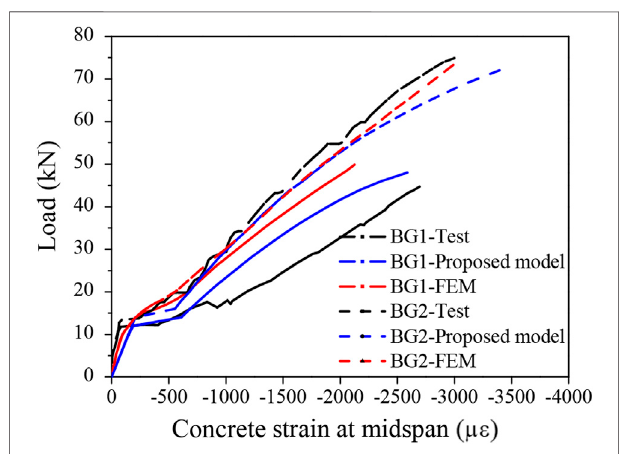
FIGURE 7 | Load-concrete strain comparison at the